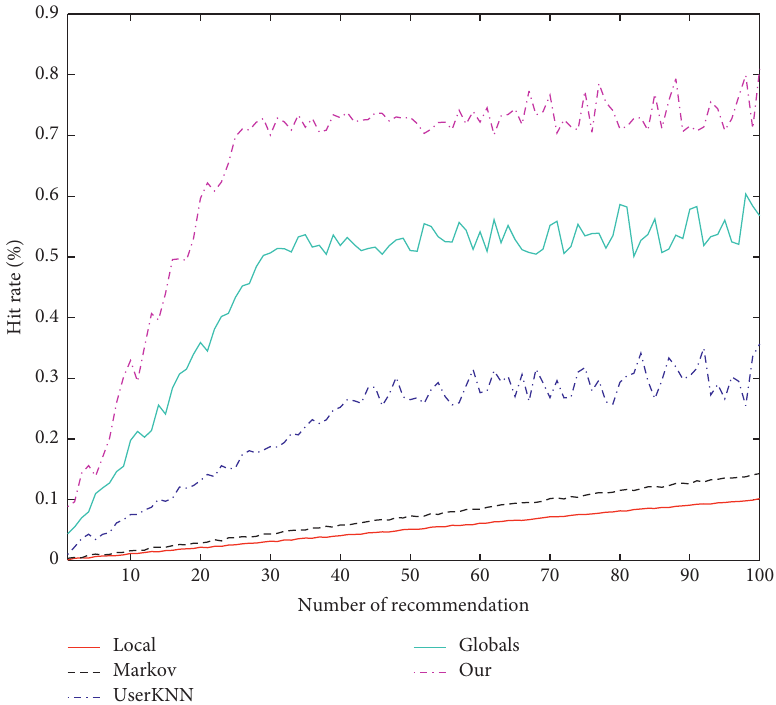
Figure 6: The simulation results of the proposed method.